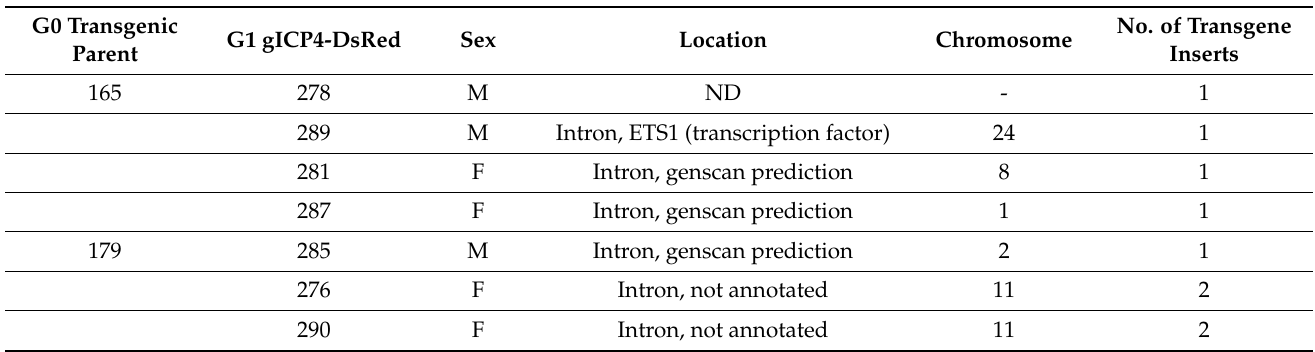
Table 3. Transgenic gICP4-DsRed parental information, sex and transgene copy number of